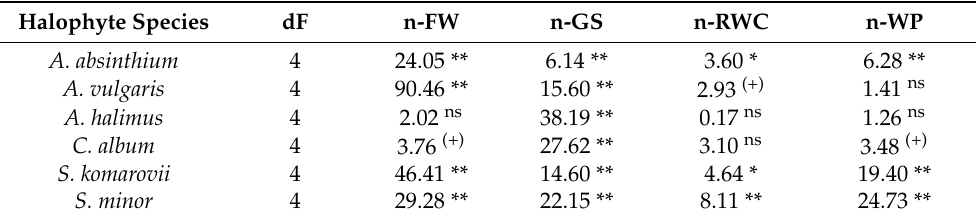
Table 2. F values and statistical significance in the one-way analysis of variance carried out on the control-normalized percent values of the four measured physiological traits: fresh weight (n-FW), stomatal conductance (n-GS), leaf relative water content (n-RWC), and leaf water potential (n-WP). Halophyte Species dF n-FW n-GS n-RWC n-WP A. absinthium 4 A. vulgaris 4 90.46 ** 15.60